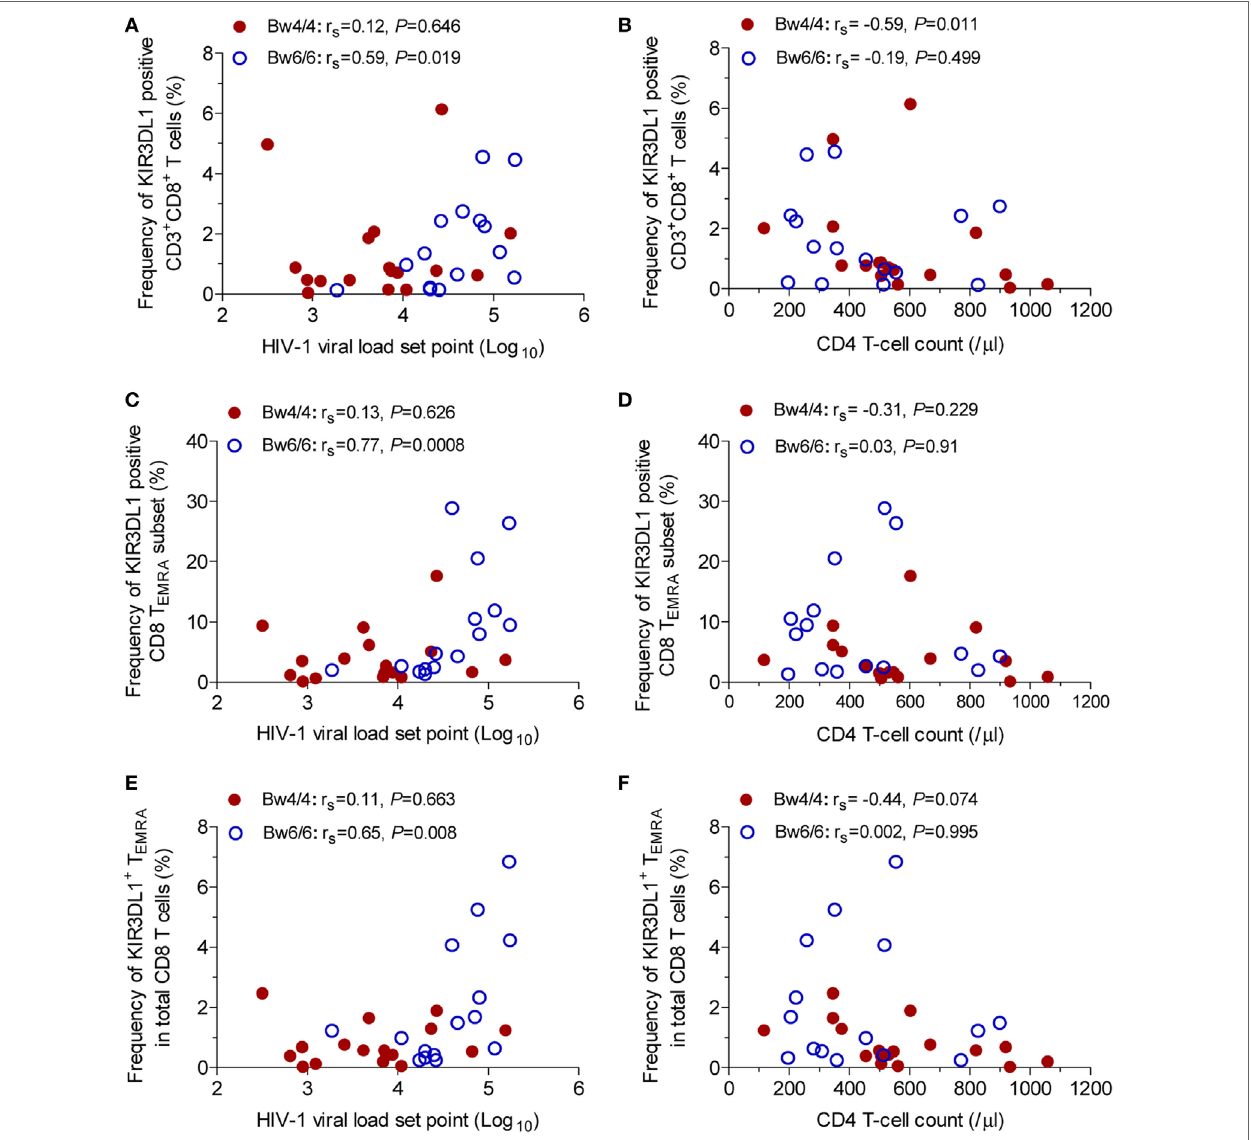
FigUre 3 | Correlation between KIR3DL1 expression on CD8 T cells with human immunodeficiency virus type 1 (HIV-1) viral load (VL) set point and CD4 T-cell count in individuals with different HLA-B serological genotypes. Correlation of KIR3DL1 expression on CD8 T cells with HIV-1 VL set point (a) and CD4 T-cell count (B) , of the percentage of CD8 T EMRA cells expressing KIR3DL1 with HIV-1 VL set point (c) and CD4 T-cell count (D) , and of KIR3DL1 + T EMRA levels as a proportion of total CD8 T cells with HIV-1 VL set point (e) and CD4 T-cell count (F) . Correlations between two variables were analyzed in non-parametric Spearman’s rank correlation tests, with P < 0.05 considered